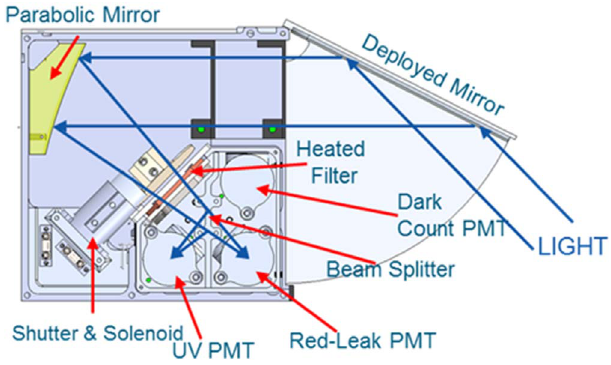
Fig. 3. Top-down view of the optical layout of the Tri-TIP sensor. (From Nicholas et al., 2019, their Fig.